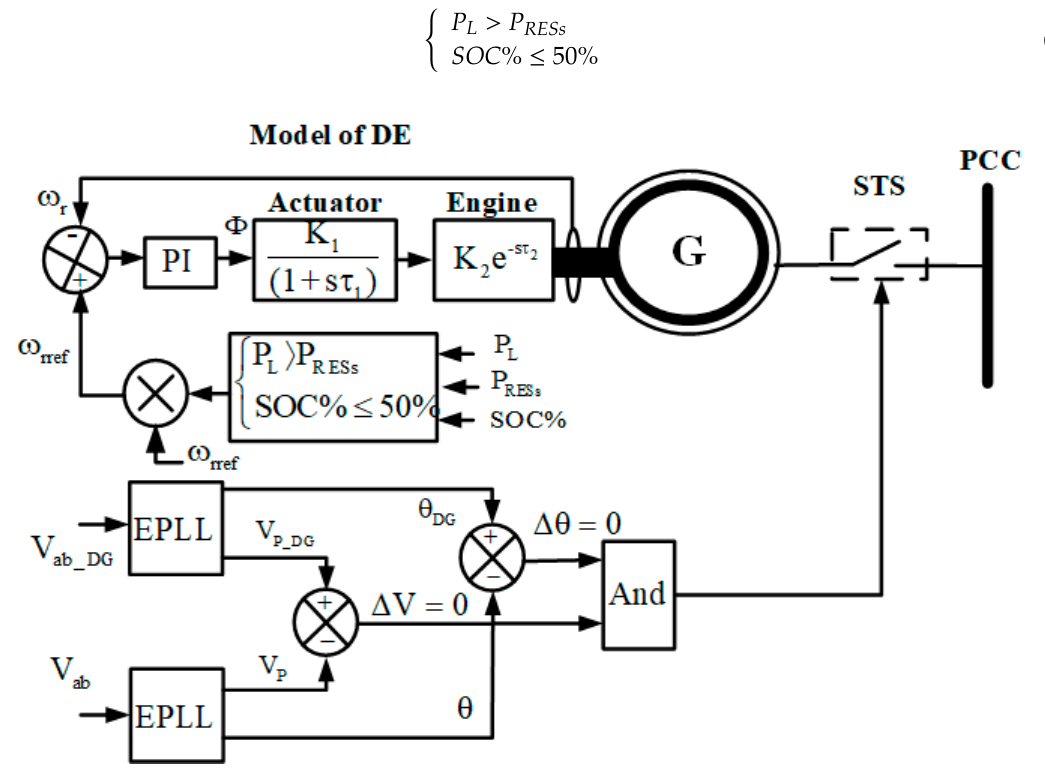
Figure 9. DG model and its control algorithm based EPLL.